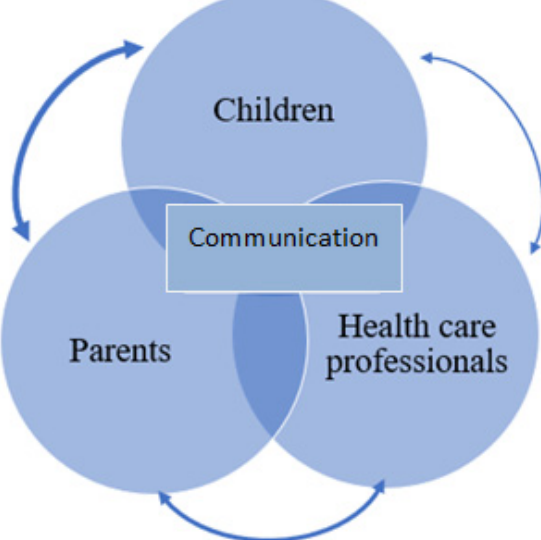
Figure 1. An illustration of the bi-directional communication interrelationships between children, parents and HCPs. For children to be informed, in an age appropriate way that also considers their emotional needs, about their parent’s illness, they need information to be communicated with them from their parent(s) and sometimes also directly from HCPs. Within this interrelationship, HCPs also have an important role in assessing, evaluating and understanding the information needs of parents and their children, to help empower parents to effectively communicate with their children. The weighted lines represent the likely importance of the different interrelationships, although these will differ for each family. For example, HCPs often help support and enhance communication between parents and children but are sometimes involved in direct communication with children.